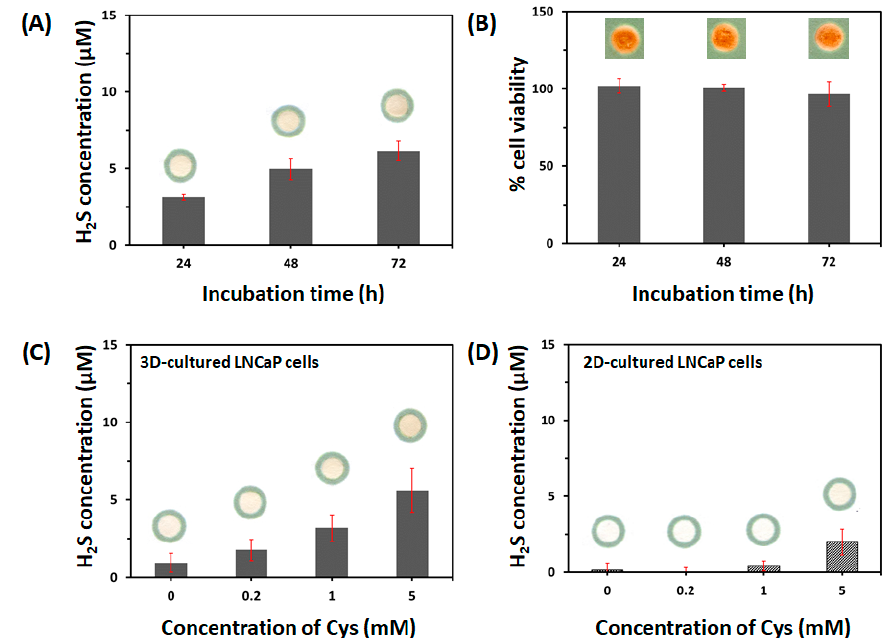
Figure 5. ( A ) Effect of duration of incubation (24, 48, or 72 h) with L-cysteine (Cys, 5 mM) on endogenous H 2 S production and ( B ) evaluation of cell viability of LNCaP cells (1.0 × 10 5 cells/zone) after culturing within the paper-integrated analytical device. The viability of LNCaP cells was quantified by the change in blue channel intensity of WST. Effects of Cys concentration (0, 0.2, 1.0, and 5.0 mM) on H 2 S release from ( C ) 3D-cultured LNCaP cells (1.0 × 10 5 cells/zone) in the paper-integrated analytical device and ( D ) 2D-cultured LNCaP cells (1.0 × 10 5 cells/well) in a 96-well microplate for 72 h, respectively. The error bars represent standard deviations (SD).